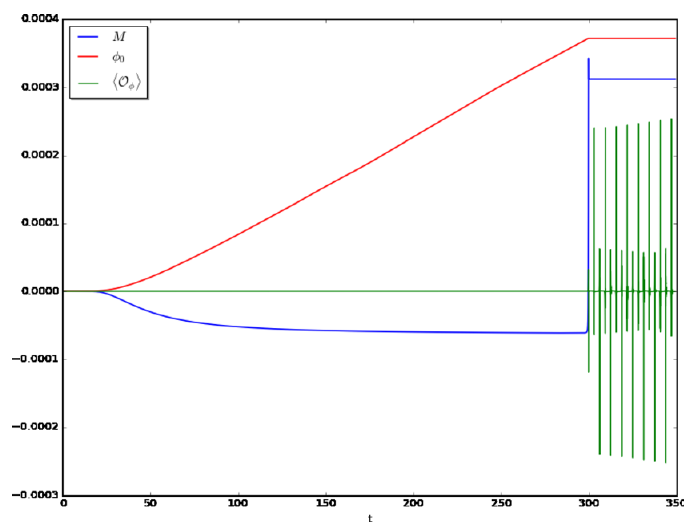
Figure 8 . Quenching o(cid:11) the pumping solution. The time span (cid:14) for the interpolation has been set to (cid:14) i = 30 for a quasi-static build up of the pumping solution and (cid:14) f = 0 : 1 for the switching o(cid:11). The actual values for (cid:30) 0 and hO (cid:30) i have been rescaled to (cid:12)t into the same (cid:12)gure. From the vev hO (cid:30) i it is apparent that the (cid:12)nal state is dynamical.